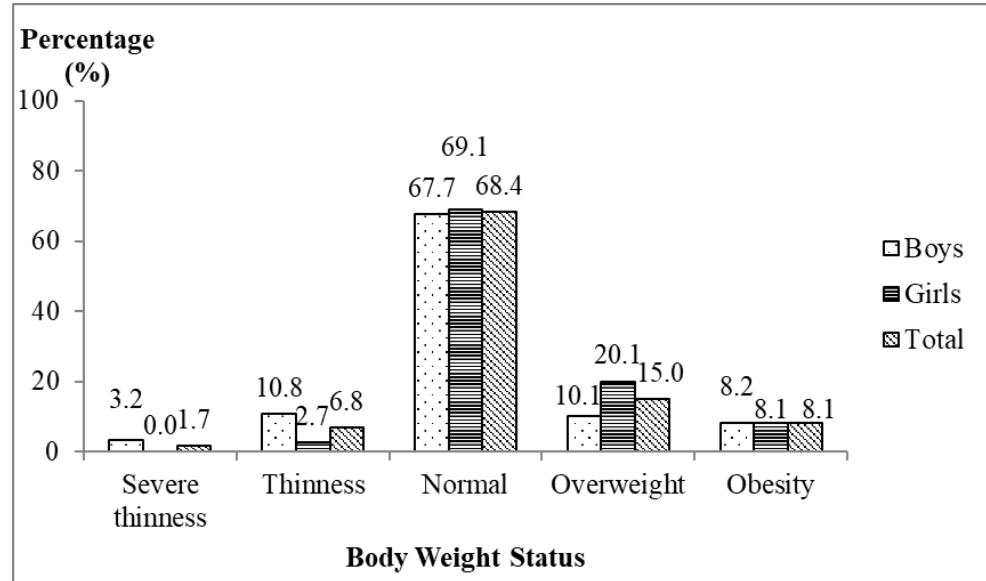
Figure 1. Distribution of respondents according to body weight status ( N = 307).